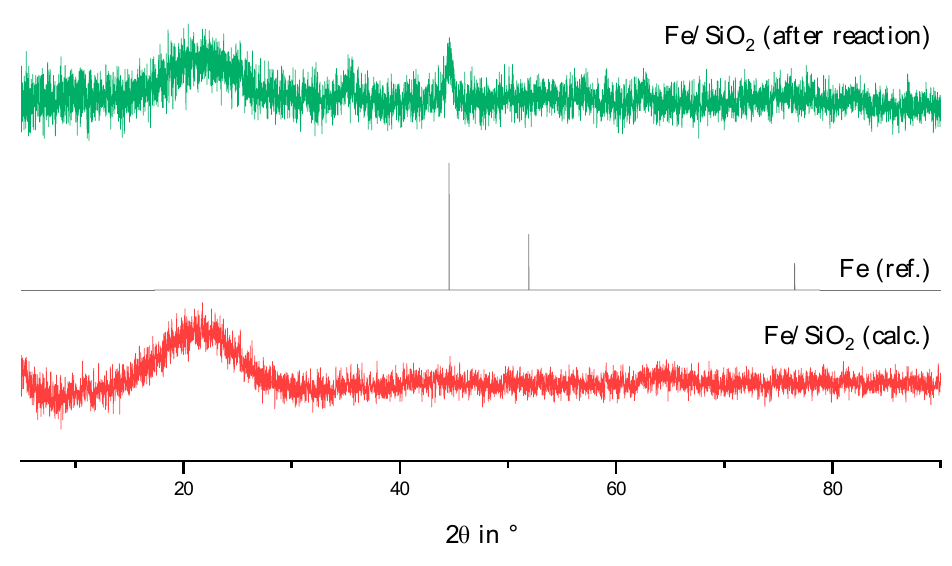
Figure A3. P-XRD of calcined tungsten catalyst before reaction (calc.) and after reaction.